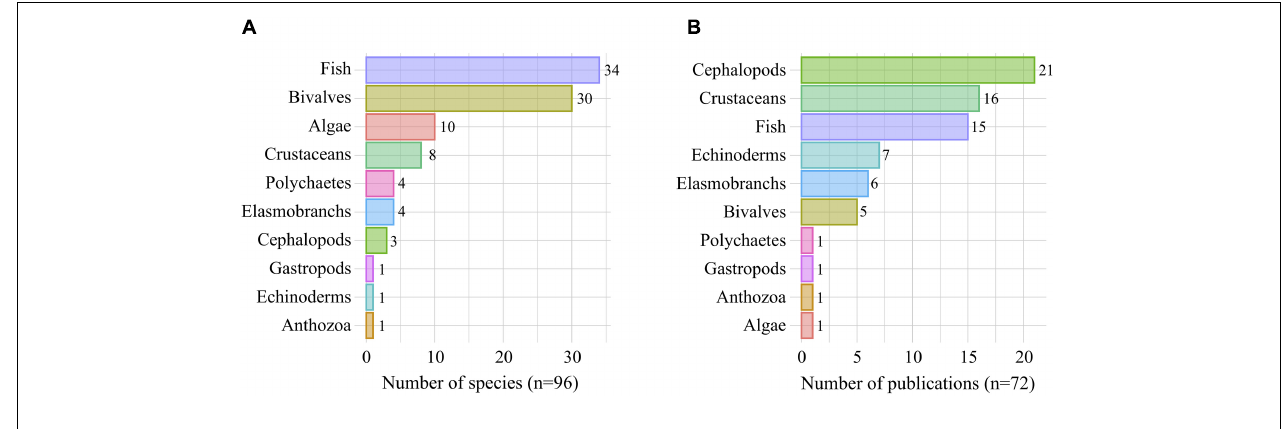
FIGURE 6 | Species (A) and publications (B) (in number) by taxonomic groups.